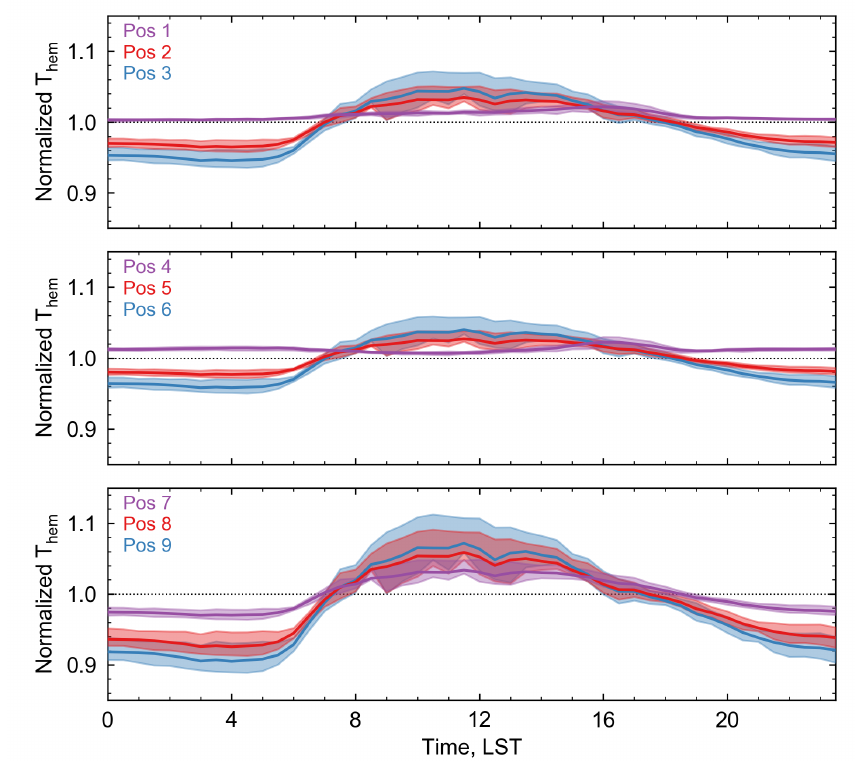
Figure A3. Mean T hem, r normalized against T comp for each sensor position over the 14-day subset of the IOP for a sensor height of 2.17 times mean building height. Shaded area indicates quartiles